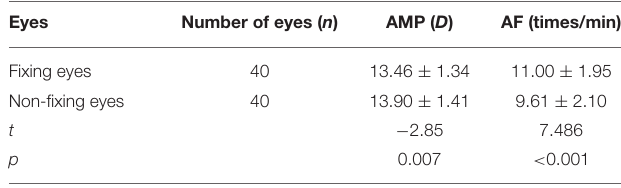
TABLE 3 | Comparison of AMP and AF between fixing eyes and non-fixing eyes in IXT children ( x ± s ).